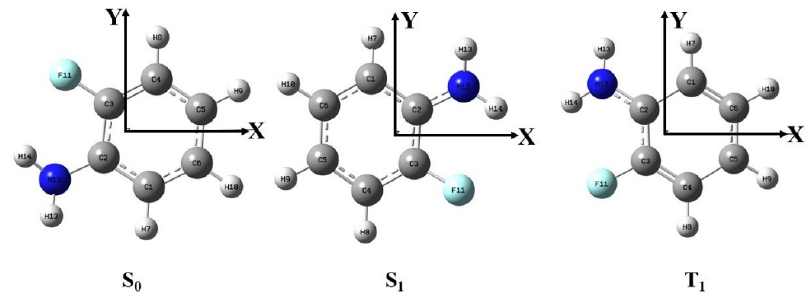
Figure A2. Molecular structure and Cartesian coordinate system of the ground state, S 1 state and T 1 state, and the Z axis is perpendicular to the paper surface. For the S 0 state, calculation method and basis set: DFT and CAM ‐ B3LYP/6 ‐ 311+G(d,p). For S 1 and T 1 states, calculation method and basis set: TD ‐ DFT and CAM ‐ B3LYP/6 ‐ 311+G(d,p).